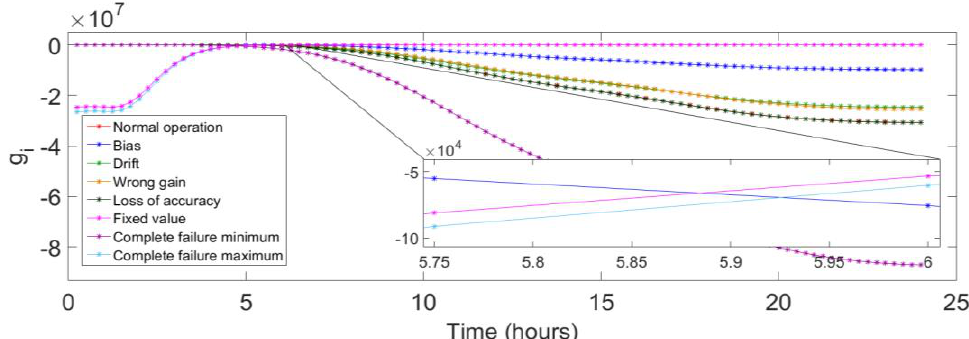
Figure 7. Fixed value diagnosis: graphs of the FDA discriminant functions g i ( x ) for each of the normal and seven fault classes, along the 24 h of the 140th day and the detailed representation revealing the class of the observations and the time moment of the firm fault type identification.